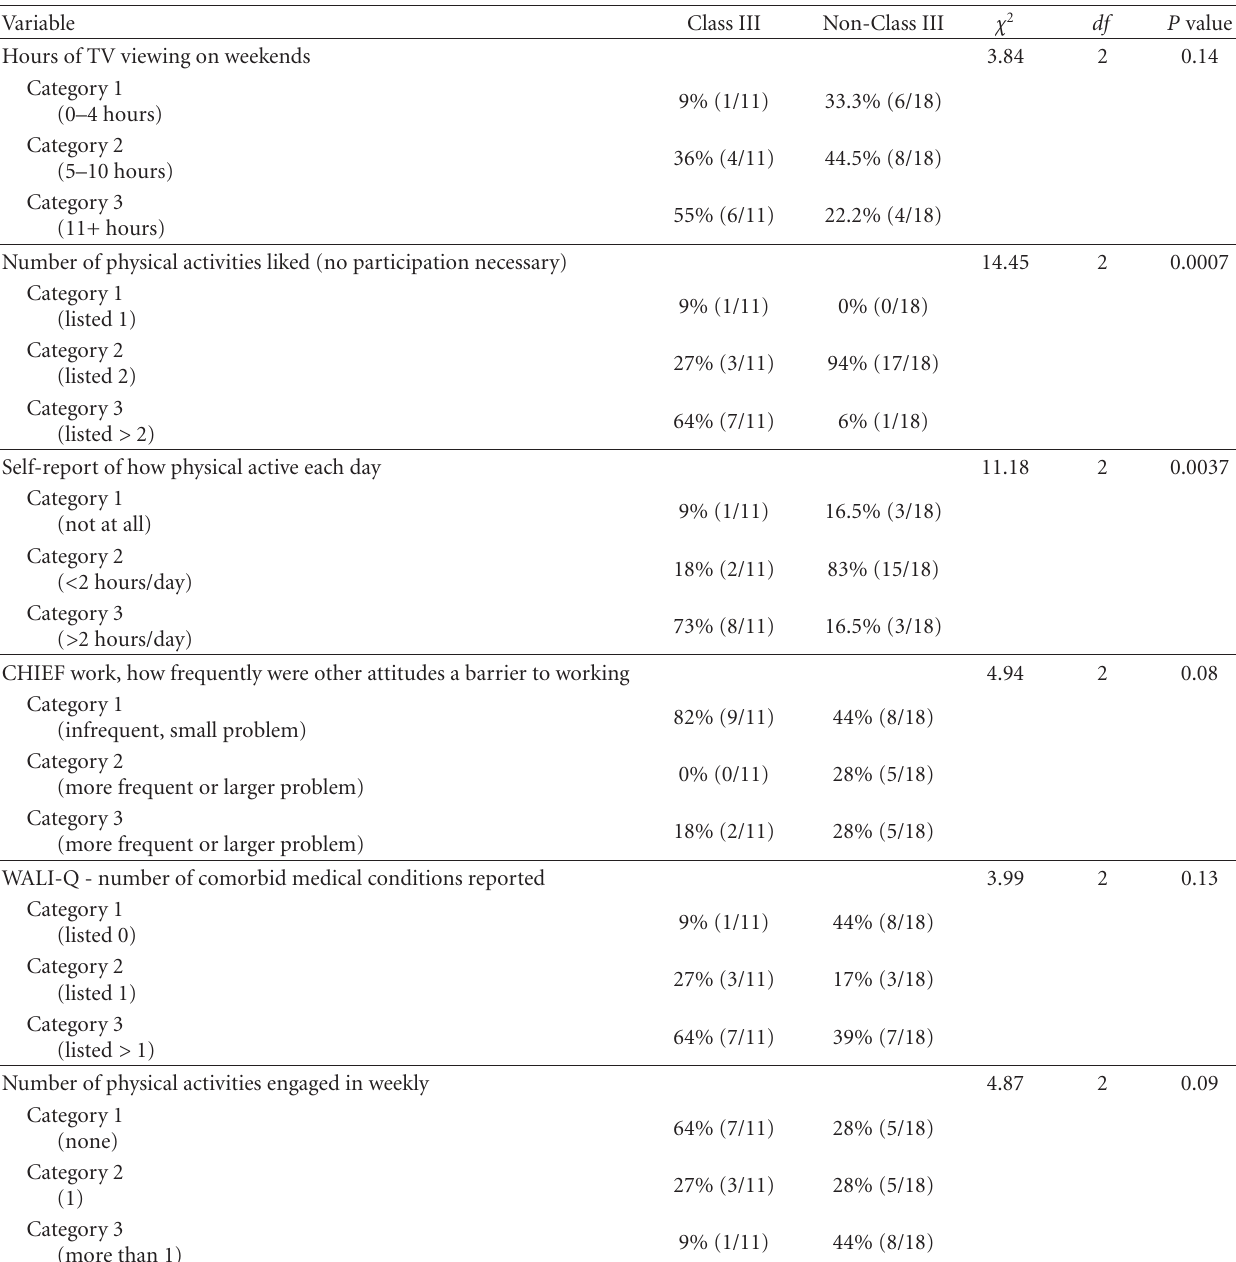
Table 3: Frequency distribution of participants by BMI group and self-reported